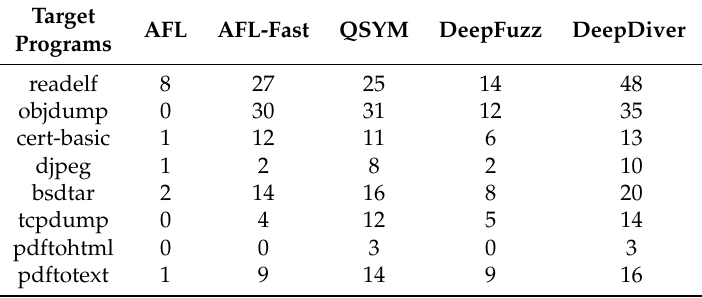
Table 5. The number of detected unique crashes in 6